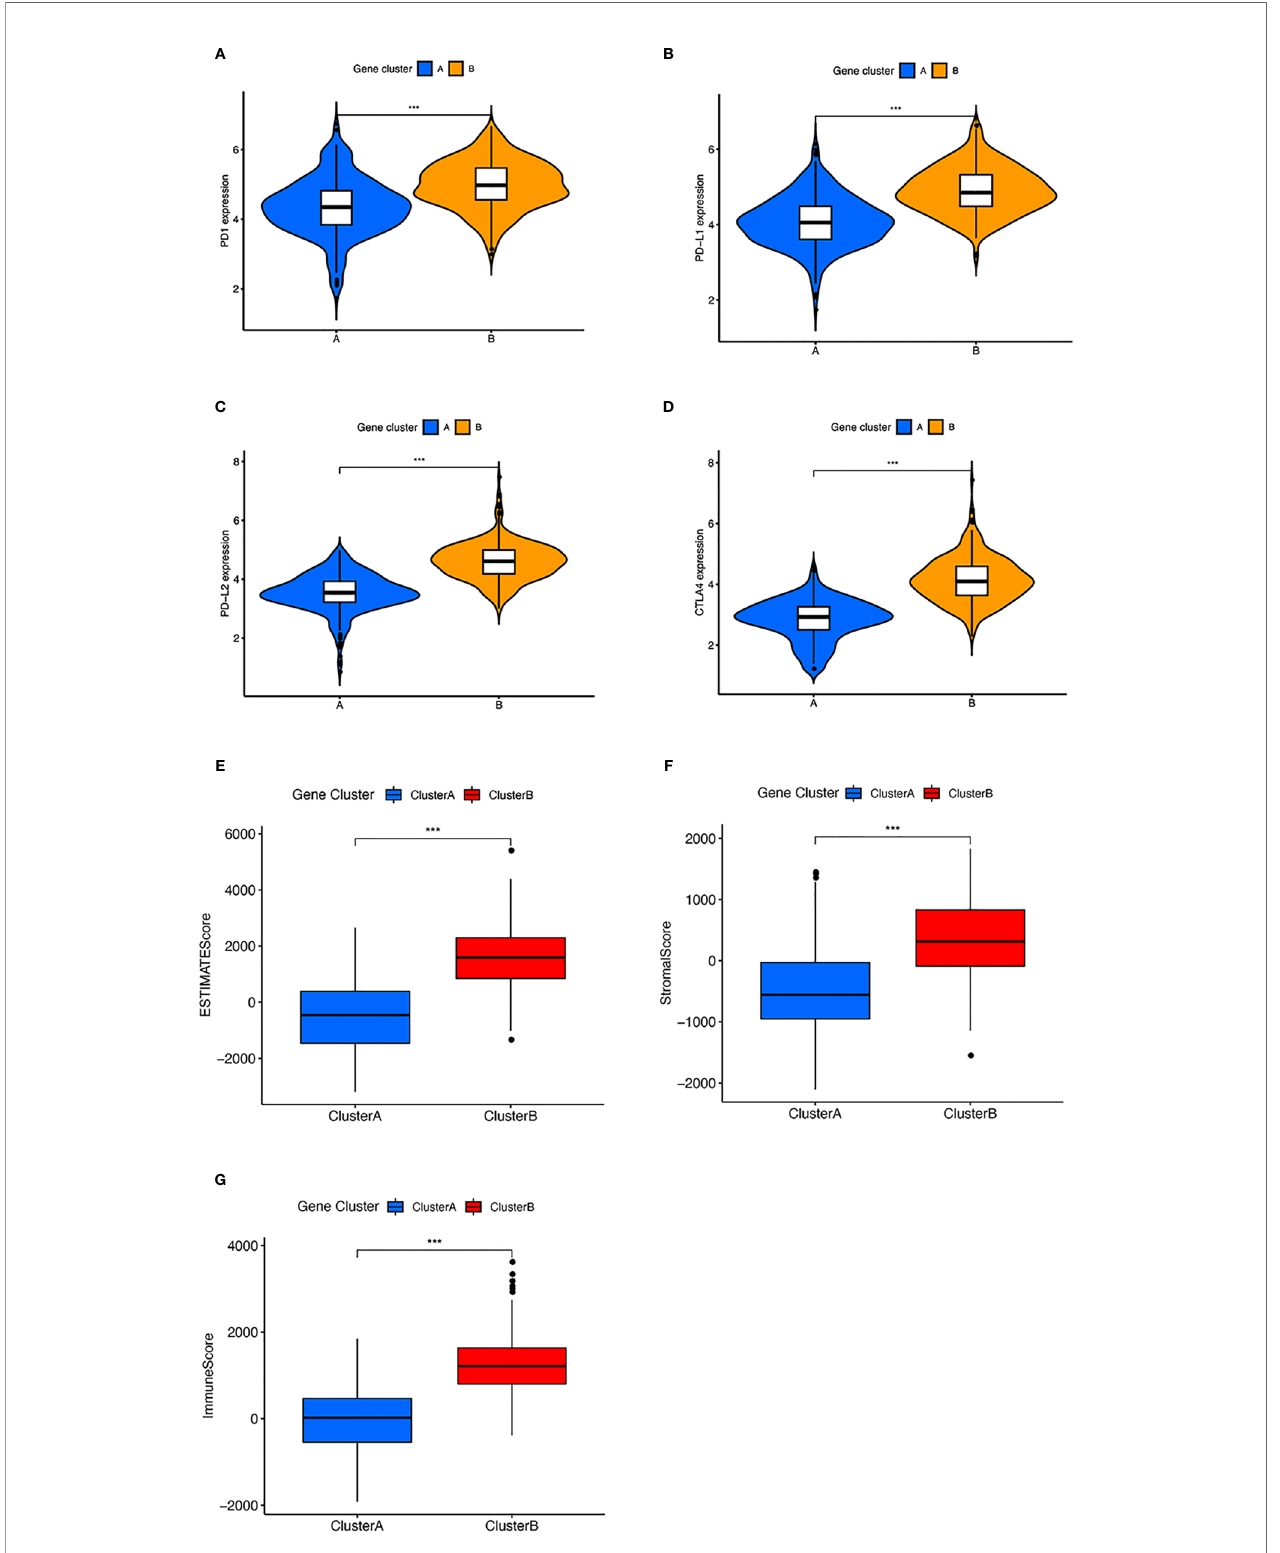
FIGURE 4 | The expression of immune checkpoint and immune related score in two clusters. (A – D) Difference in (A) PD-1, (B) PD-L1, (C) PD-L2, and (D) CTLA4 expression between two gene clusters. (E – G) Difference in ESIMATE score, stromal score, and immune score between two gene clusters. *** p <